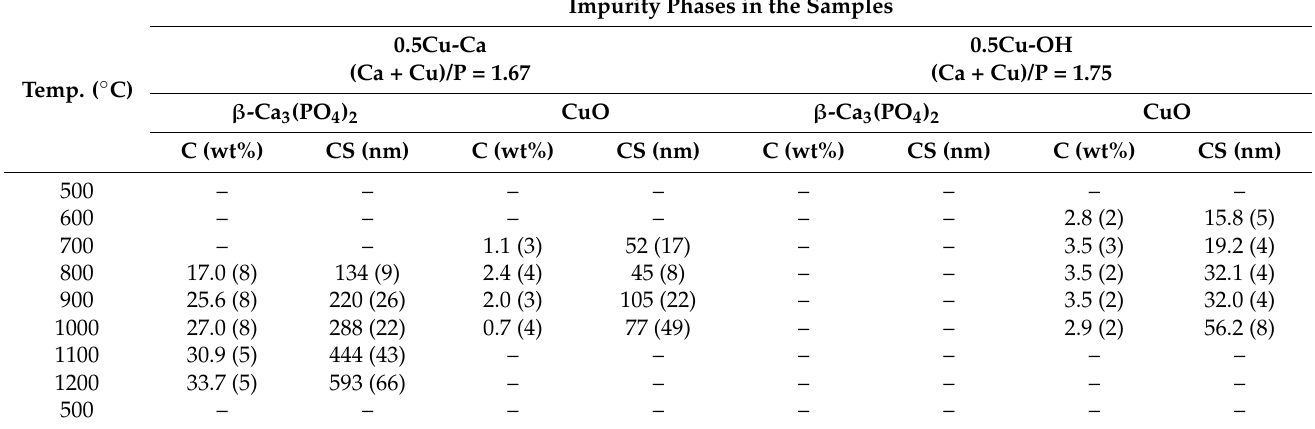
Table 3. Concentrations (C) of impurity phases and changes in crystallite size (CS) of the substituted- HA samples during the in situ